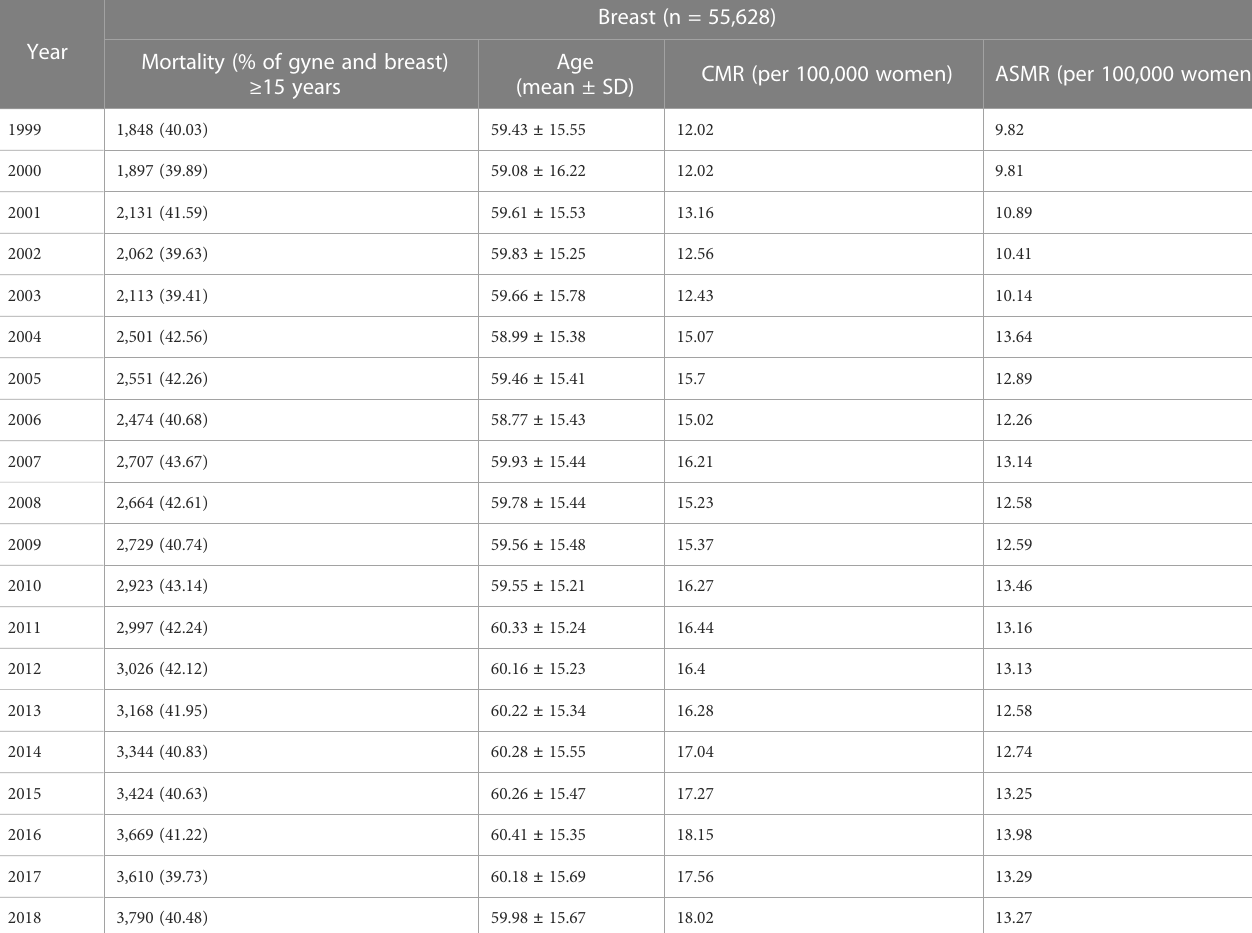
TABLE 1 Trends in the mortality rates and mean age at death of breast cancer in South Africa (1999 –